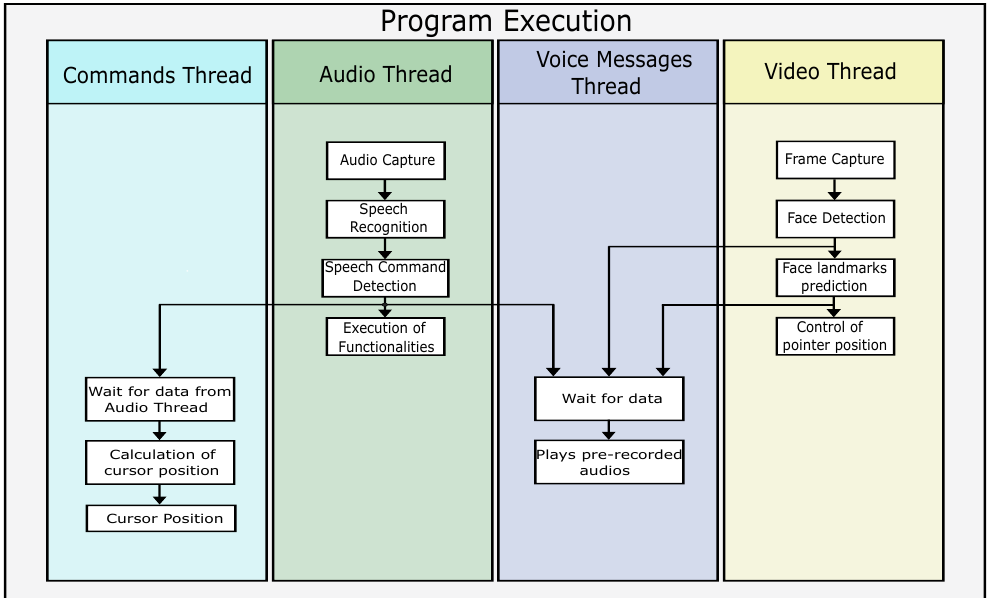
Figure 2. Program execution